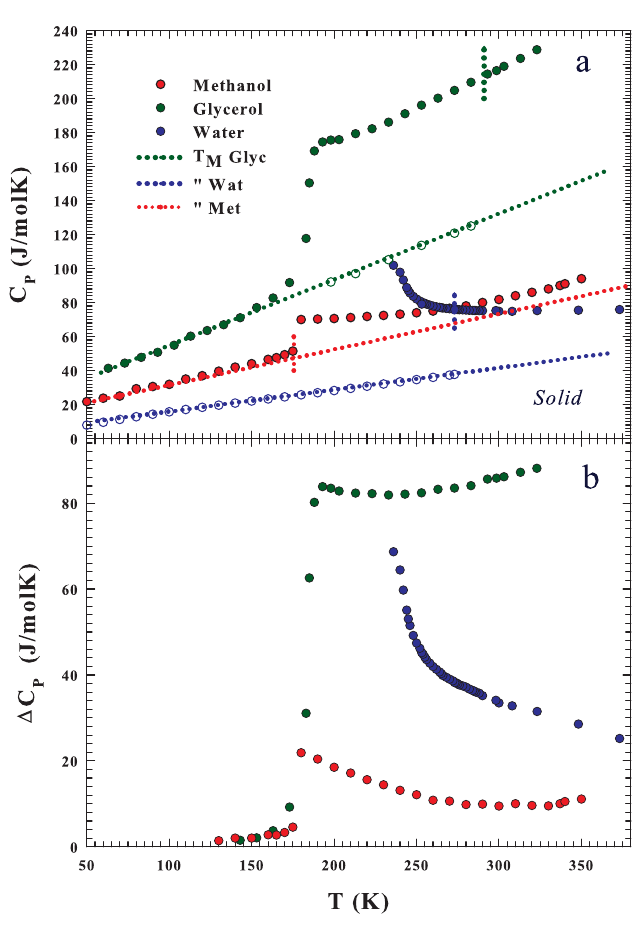
Figure 5. The water [75,76,78], methanol [79], and glycerol [74] C P ( T ) values measured ( a ) as a function of the temperature in their liquid (stable and supercooled) and solid phases (open circles and their interpolation as straight dotted lines). Their melting temperatures (vertical dotted lines) are also reported. As can be observed, the water and methanol specific heats cross at about 265 K. As theoretically proposed for water, we can assume [82] that the difference between the liquid and solid specific heat can give a good estimation of the configurational contribution; such a difference for the three substances, C P , conf (cid:39) ∆ C P = C P , liq − C P , sol , is proposed in ( b